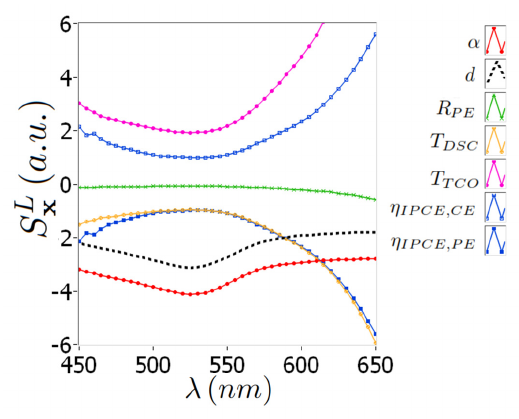
Figure 4. L diff sensitivity functions with respect to α , d , T TCO , R PE and T DSC . For S L diff α , S L diff